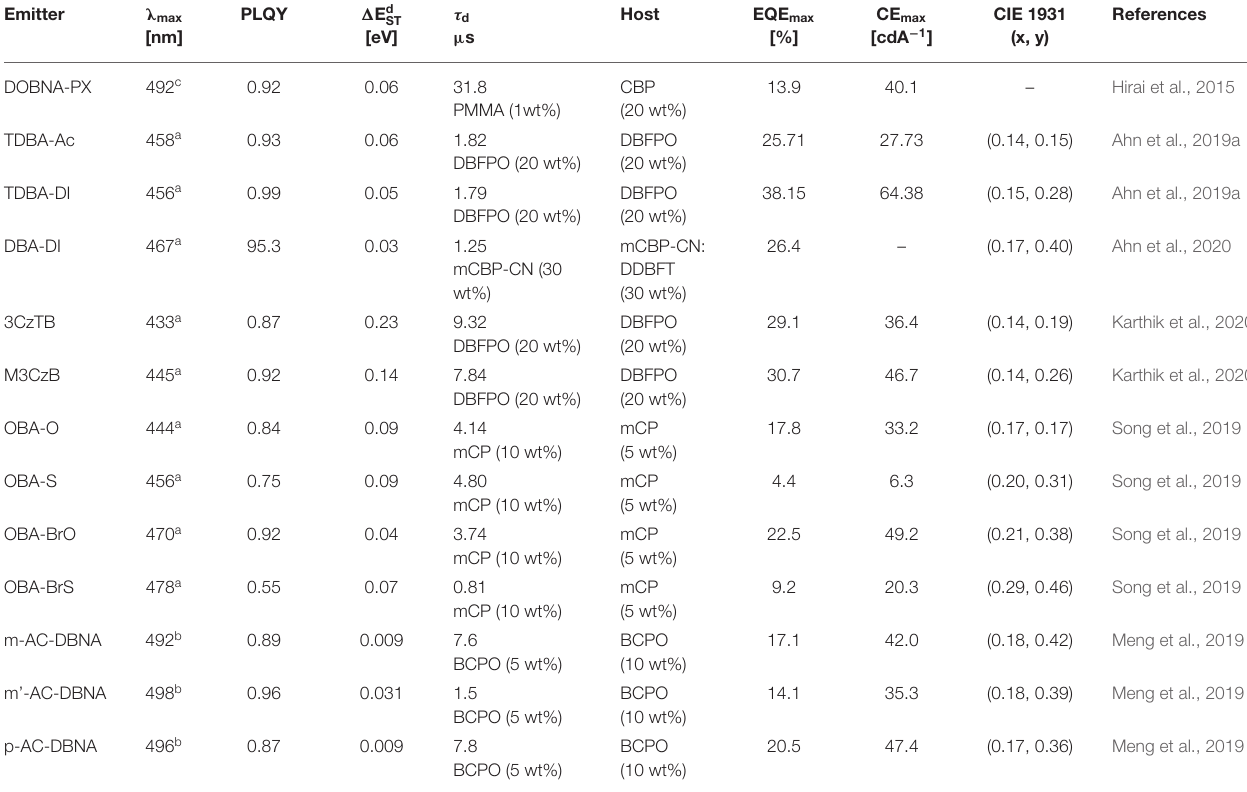
TABLE 4 | Summary of photophysical and device characteristics of the oxygen-based fully bridged boron type blue thermally activated delayed fluorescence (TADF) emitters.